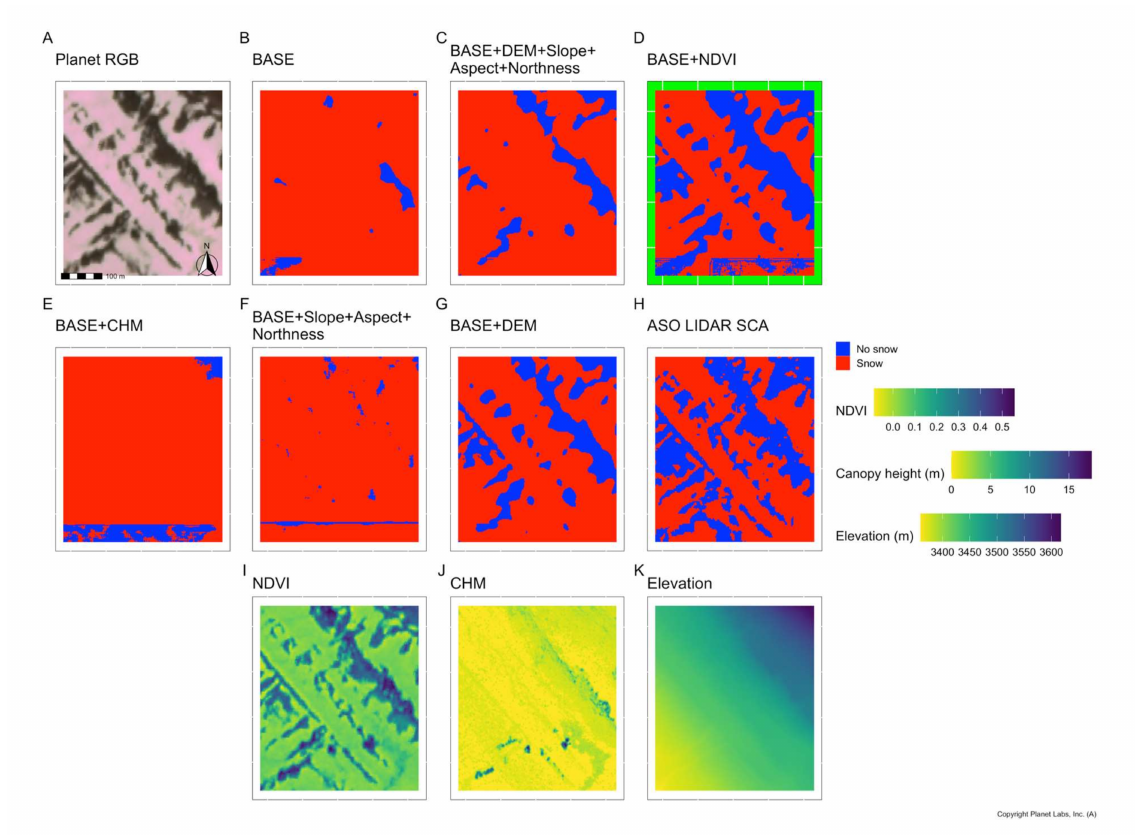
Figure 8. Performance of models in a sample area in Gunnison that is predominantly an open area. ( A ) Planet RGB imagery showing the sample area in the Gunnison study site. ( B ) SCA predicted by the BASE model. ( C ) SCA predicted by the BASE + DEM + slope + aspect + northness model. ( D ) SCA predicted by the BASE + NDVI model, the best performing model. ( E ) SCA predicted by the BASE + CHM model. ( F ) SCA predicted by the BASE + slope + aspect + northness. ( G ) SCA predicted by the BASE + DEM. ( H ) Lidar-derived SCA. Total sub study area of approximately 0.25 km 2 . The highlighted model in green is the overall best model, Model 1. ( I ) Corresponding NDVI of the sample area derived from PlanetScope image. ( J ) Canopy height of the sample area that shows sparseness in canopy cover. ( K ) Elevation of the study area showing little variation. Note that the tiles were aggregated for this visualization and show some visible artifacts (border lines). The satellite imagery in panel ( A ) was downloaded from Planet Labs, Inc. All rights